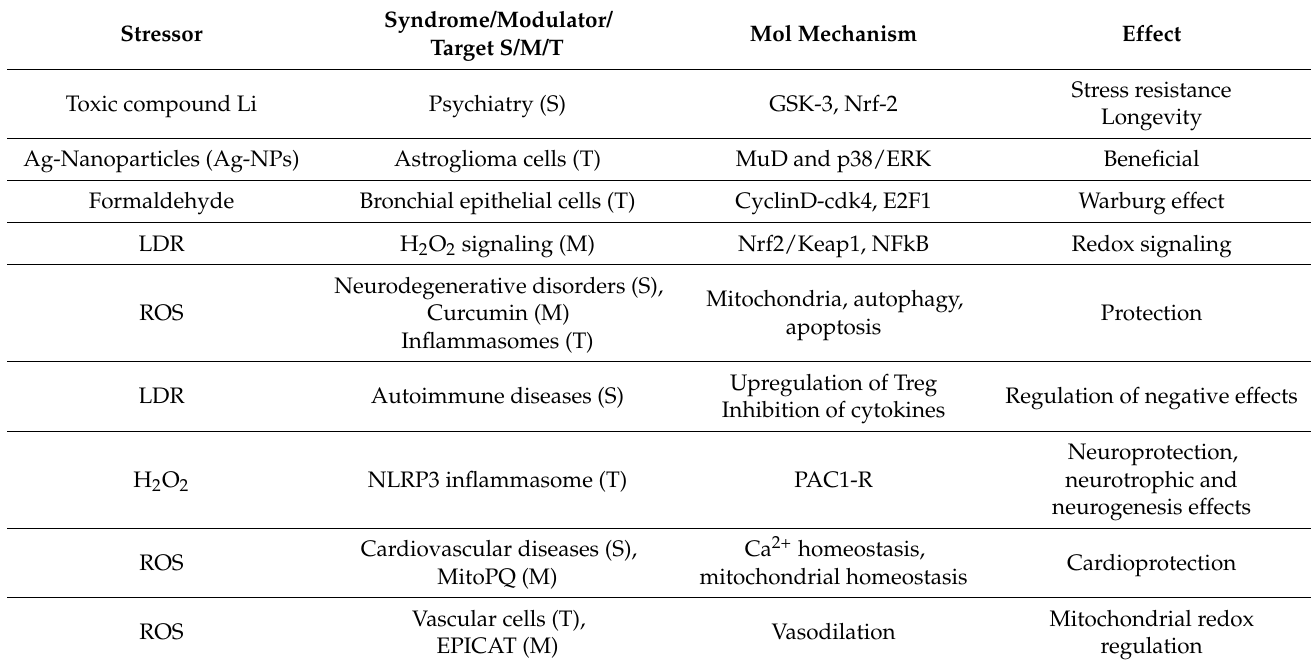
Table 4. Clinical